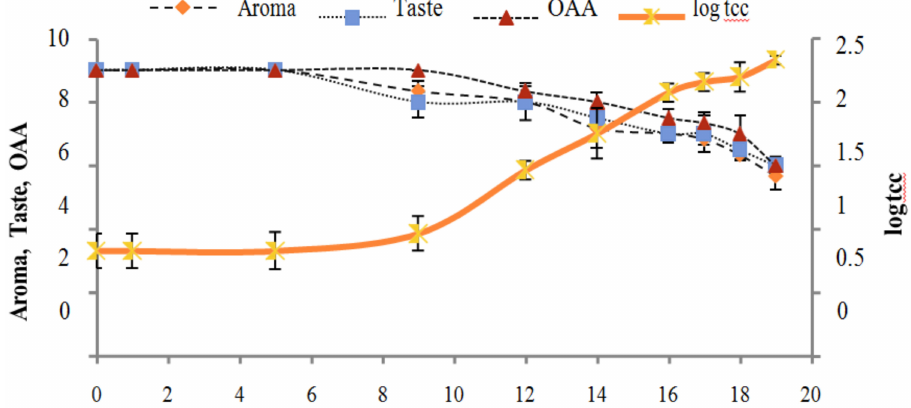
Figure 2. Relationship of total coliform count Log CFU/mL growth trends with sensory scores of pasteurized milk for spoilage detection stored at 4 ◦